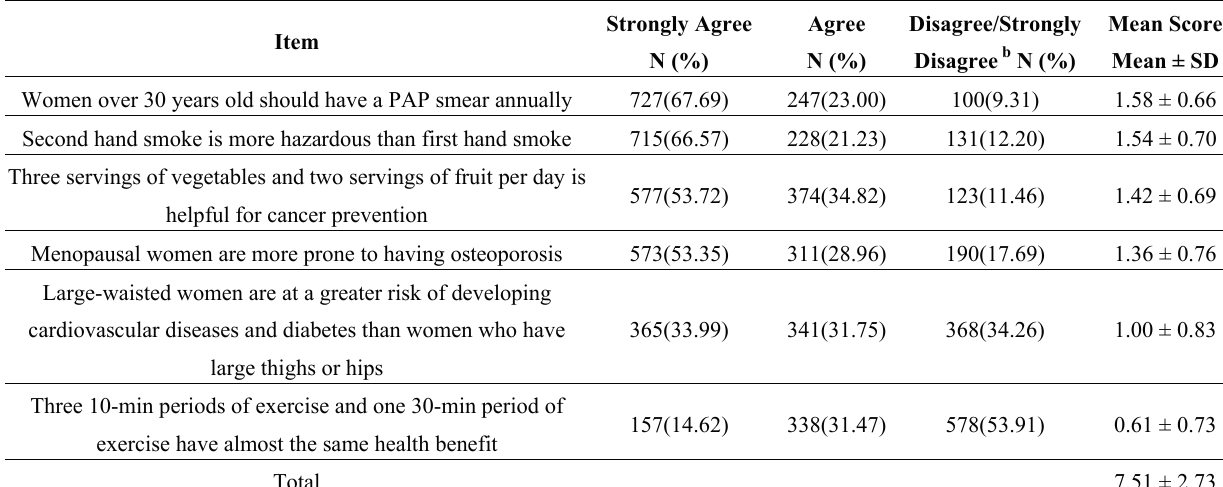
Table 2. Distribution of agreement with publically promoted health messages a ( N = 1074). Item